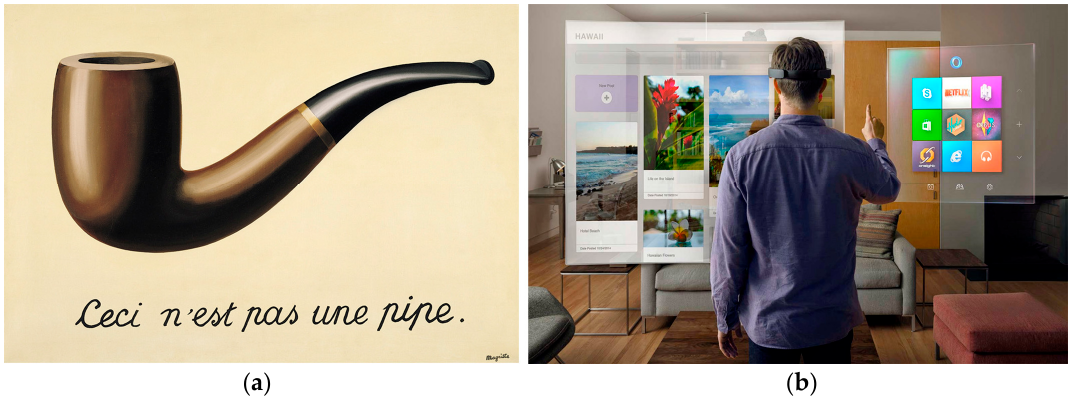
Figure 3. Is it truer an avowedly false image or a virtual one that pretends to be true? ( a ) René Magritte, La trahison des images , Los Angeles County Museum of Art, 1928–1929; ( b ) Advertising image of Microsoft Hololens